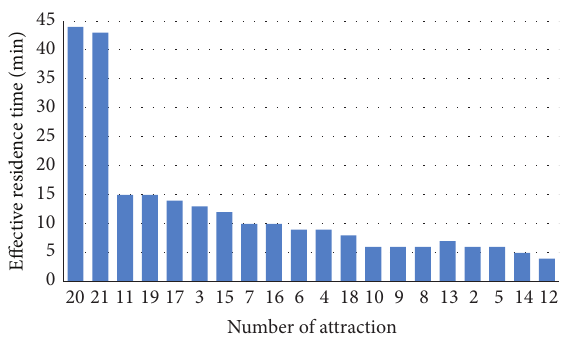
Figure 5: Effective residence time.